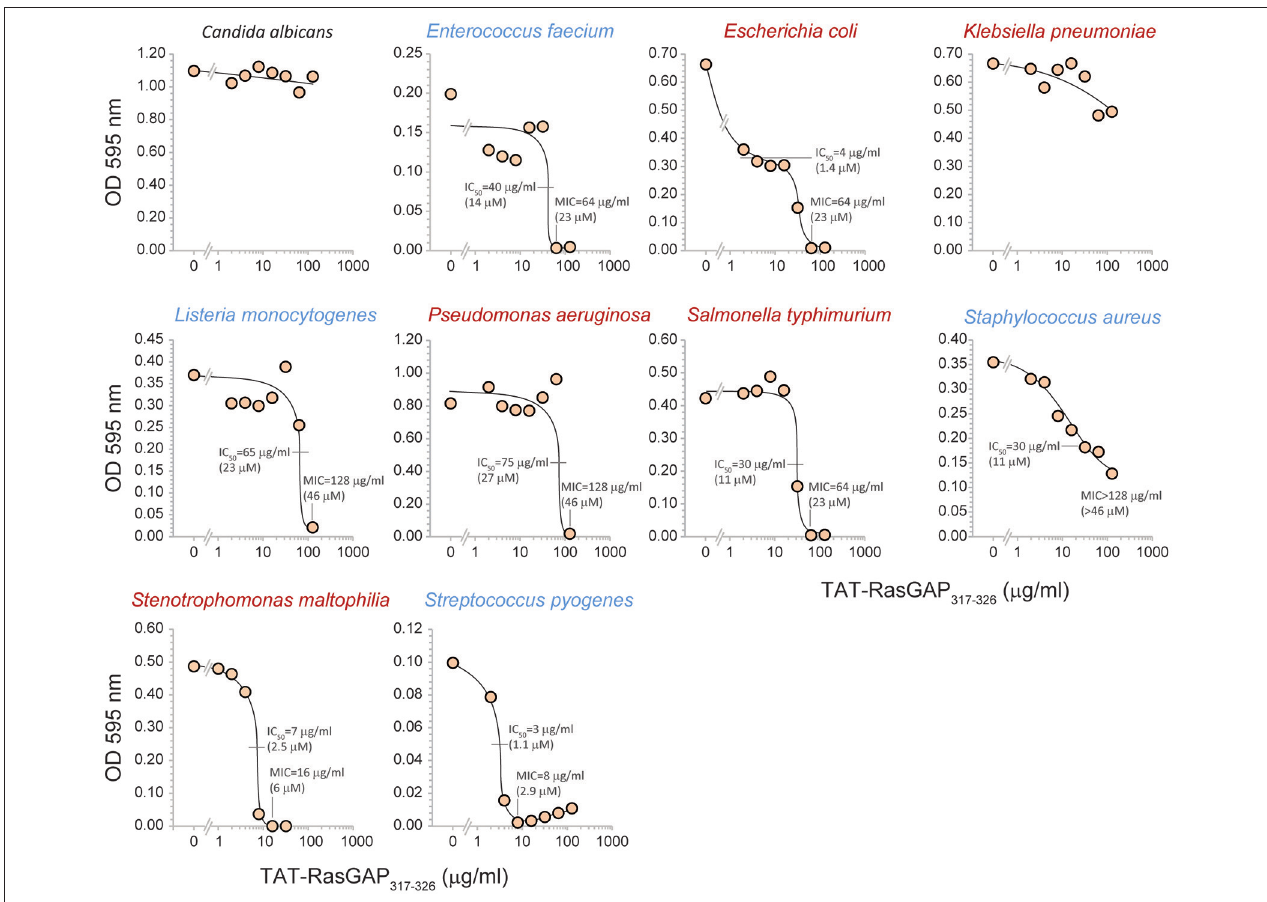
FIGURE 3 | TAT-RasGAP 317 − 326 -mediated growth inhibition of pathogenic clinical strains. The indicated bacteria isolates were grown in presence of the indicated concentrations of TAT-RasGAP 317 − 326 . The OD 595 nm was measured after 16h of incubation at 37 ◦ C. IC 50 , fifty percent maximal inhibitory concentration; MIC, Minimal inhibitory concentration.